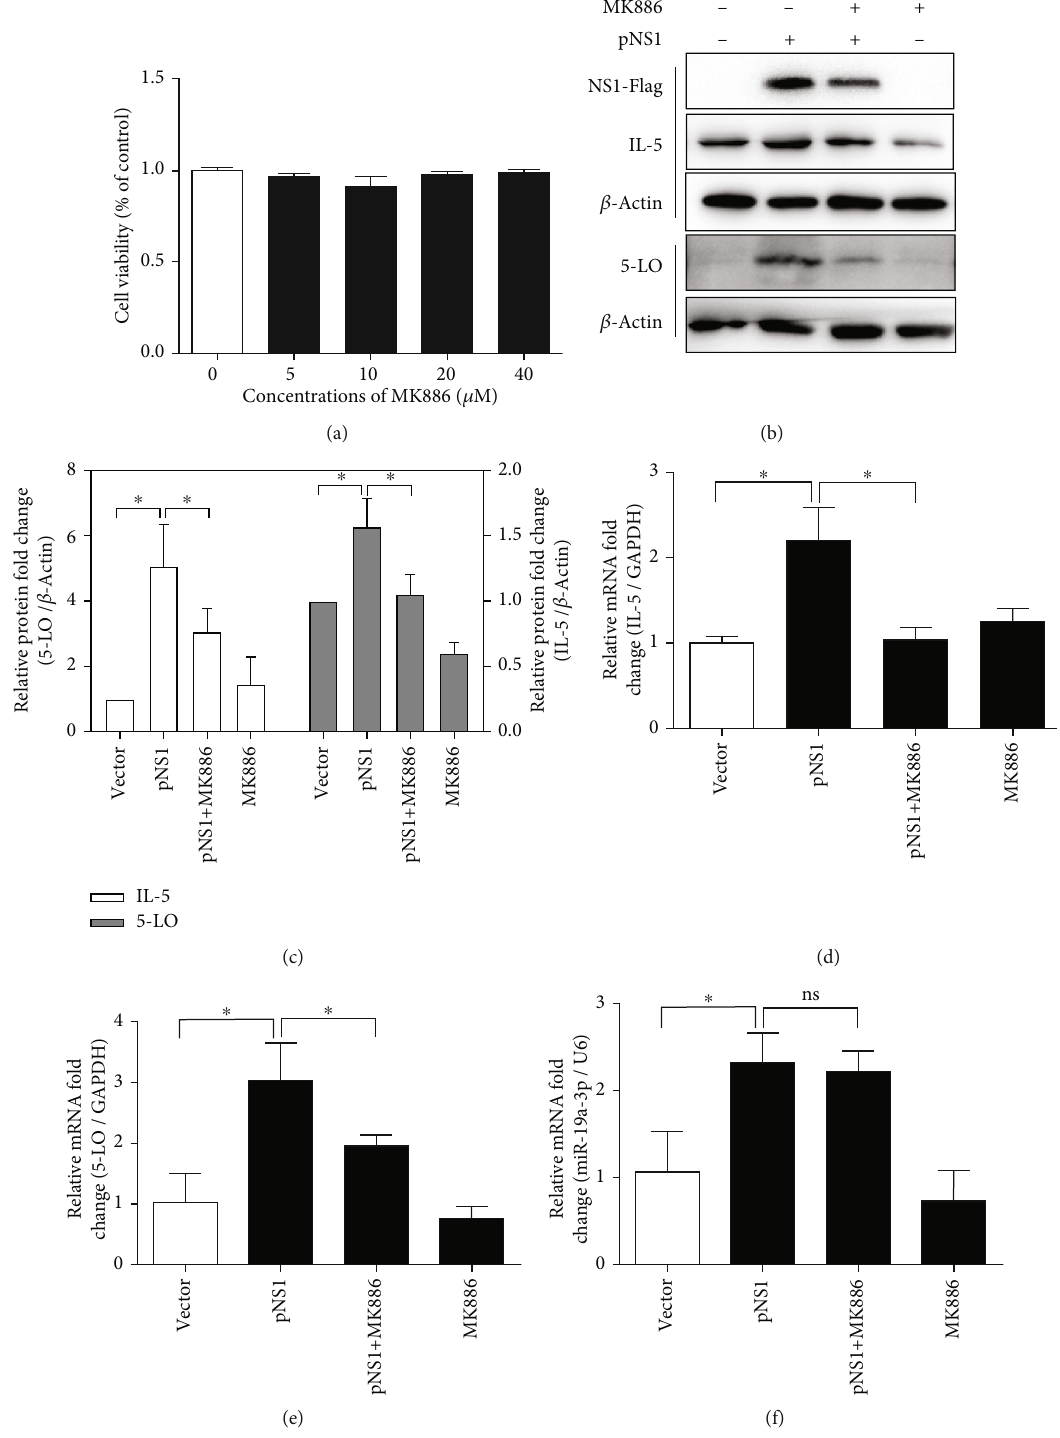
Figure 4: Inhibition of 5-lipoxygenase (5-LO) attenuates the promotive e ff ects of NS1 on IL-5 but had no e ff ect on miR-19a-3p. (a) A549 cells were treated with MK886 of di ff erent concentrations, and the cell viability was assessed after 4 hours using cell counting kit-8 assay. Data are reported as the percentage relative to 0 μ M. (b) Western blot analysis of 5-LO, IL-5, and NS1 protein levels in A549 cells transfected with pNS1 four hours after transfection. (c) Relative quantitative analysis of 5-LO protein and IL-5 protein, respectively. β -Actin served as an internal control. (d – f) The mRNA expression levels of miR-19a-3p, IL-5, and 5-LO in A549 cells transfected with pNS1 were detected by RT- qPCR four hours after transfection. U6 RNA or GADPH was used as internal control, respectively. Data are expressed as mean ± SD ( n = 3 technical replicates). The experiment was performed three times with similar results, and one representative experiment is shown. ∗ P < 0 : 5 vs. control group. NS1: nonstructural protein 1; pNS1: nonstructural protein 1 expressing plasmid; 5-LO: 5-lipoxygenase; IL-5: